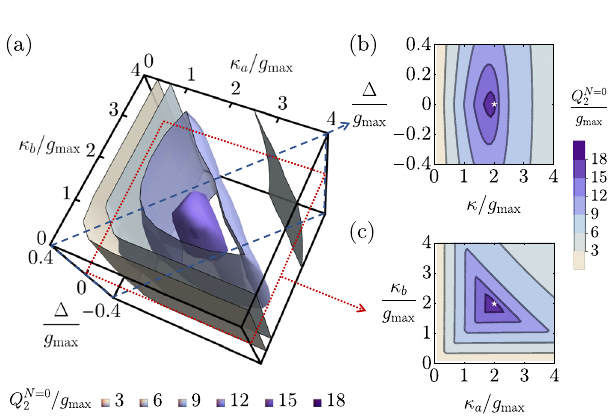
Fig. 6 | Diagramsfor thenumericalsearch oftheoptimized0-stagetransducer parameters that can attain the highest possible continuous-time two-way pure-loss quantum capacity. a Contour plot of the continuous-time two-way pure-losscapacityfor N =0, Q N =0 2 ,intheparameterspaceof κ a , κ b ,and Δ ≡ Δ a − Δ b . b A slice in the parameter spacewith symmetric external coupling rates κ a = κ b = κ . The white starrepresents the location ofthe maximally fl atparameters. c A slicein the parameter spaceunder the resonant condition Δ =0.Thewhitestar represents the location of the maximally fl at parameters.